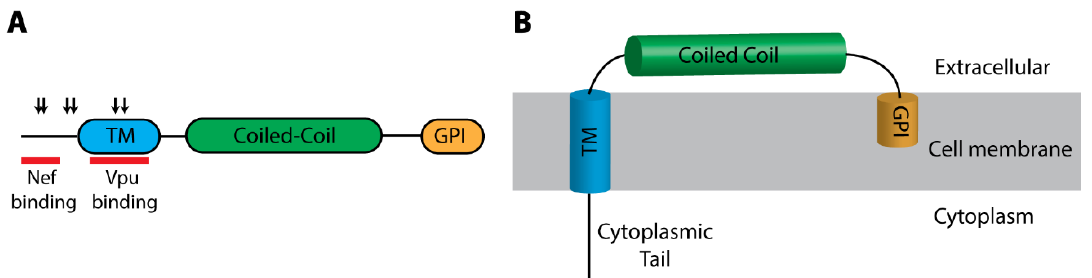
Figure 4. BST2 domain organization and membrane association. ( A ) Schematic diagram of the domain organization of BST2. Positively selected residues are identified by down arrows [345,346]. Regions of HIV-1 Vpu and Nef interaction are indicated with red bars [347,348]. ( B ) Structural representation of BST2 as a transmembrane protein with a GPI anchor. TM, transmembrane domain; GPI, glycosylphosphatidylinositol anchor.